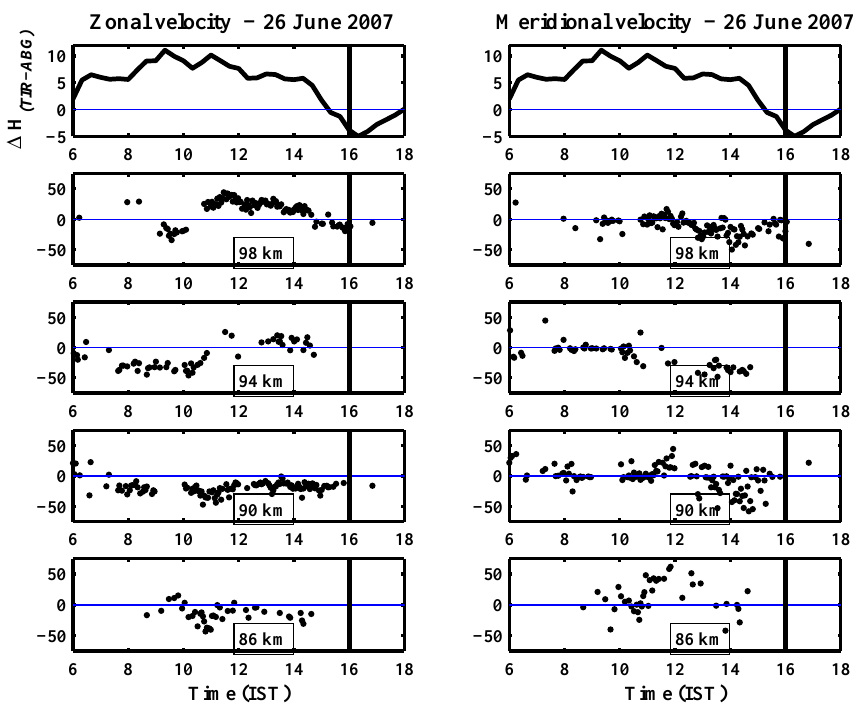
Fig. 2d. [ 1H TIR − 1H ABG ] (top panels) and zonal and meridional velocities at 86, 90, 94 and 98km (remaining panels) on 26 June 2007. See text for more